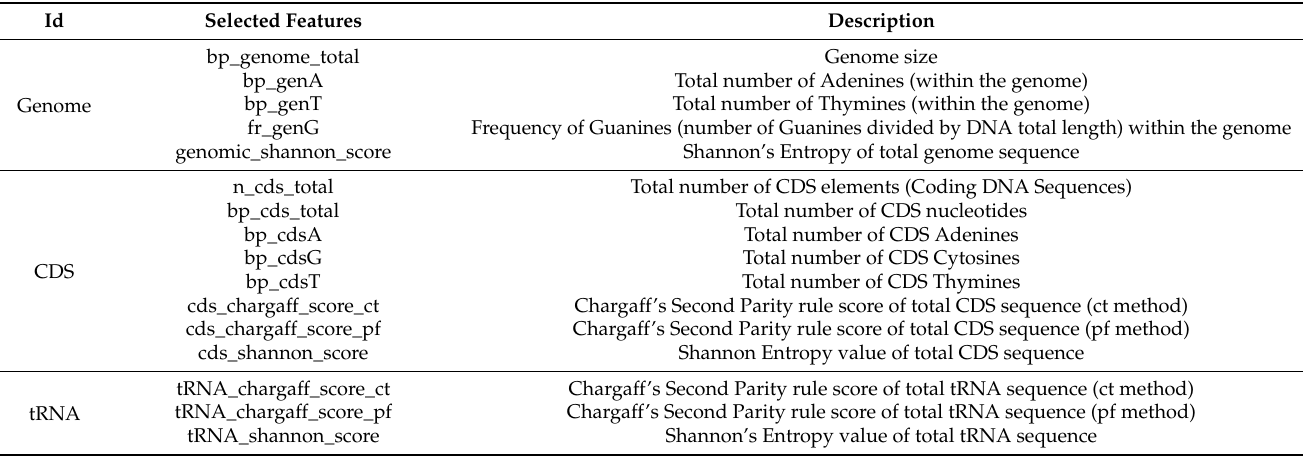
Table 1. Selected features (n = 16) identified using the most parsimonious and performant model (prediction accuracy = 90.9%).